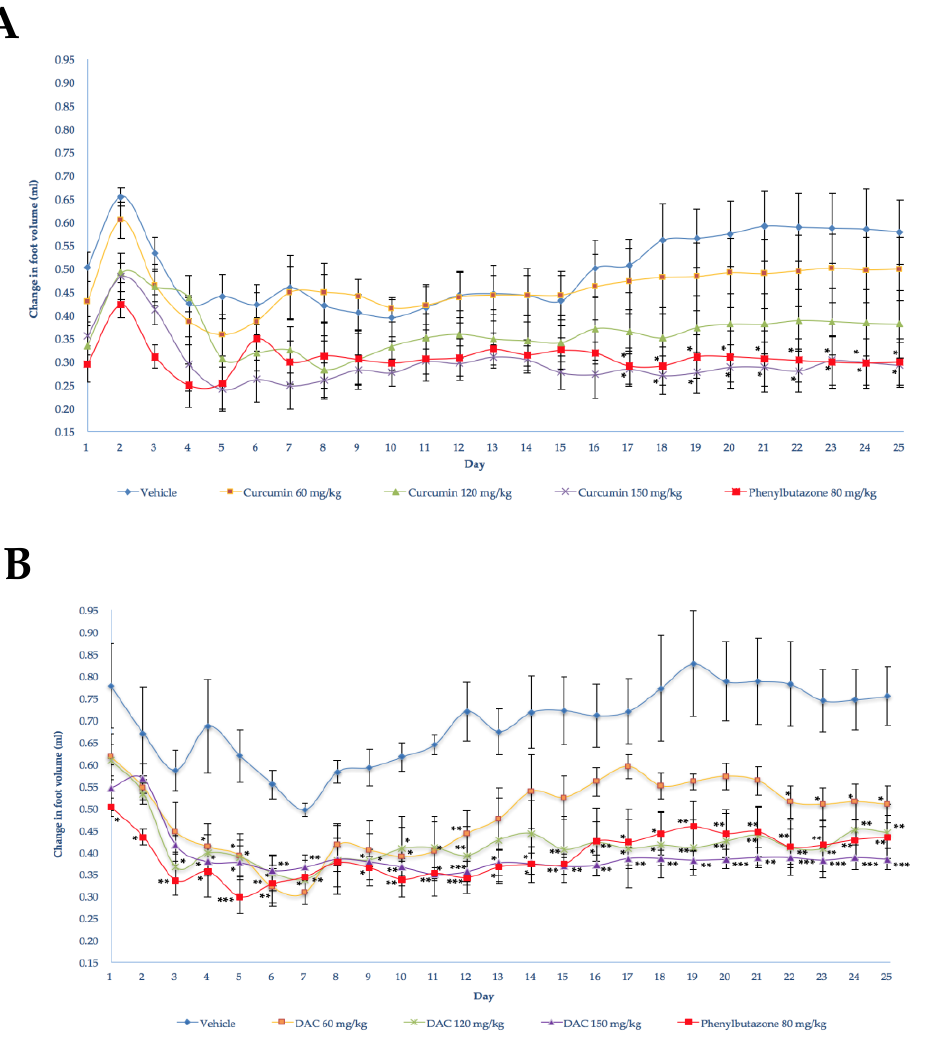
Figure 2. Antiinflammatory effect during the chronic phase of the oral administration of phenylbutazone (80 mg/kg), ( A ) curcumin, and ( B ) diacetylcurcumin (DAC) (60, 120, and 150 mg/kg) upon the edema induced by intradermal injection of Freund’s complete adjuvant into the footpad of right rear limbs of Wistar rats. Each point represents the mean ± SEM ( n = 5). ANOVA followed by Tukey’s test. p < 0.05, 0.01 and 0.001 (*, ** and *** respectively).